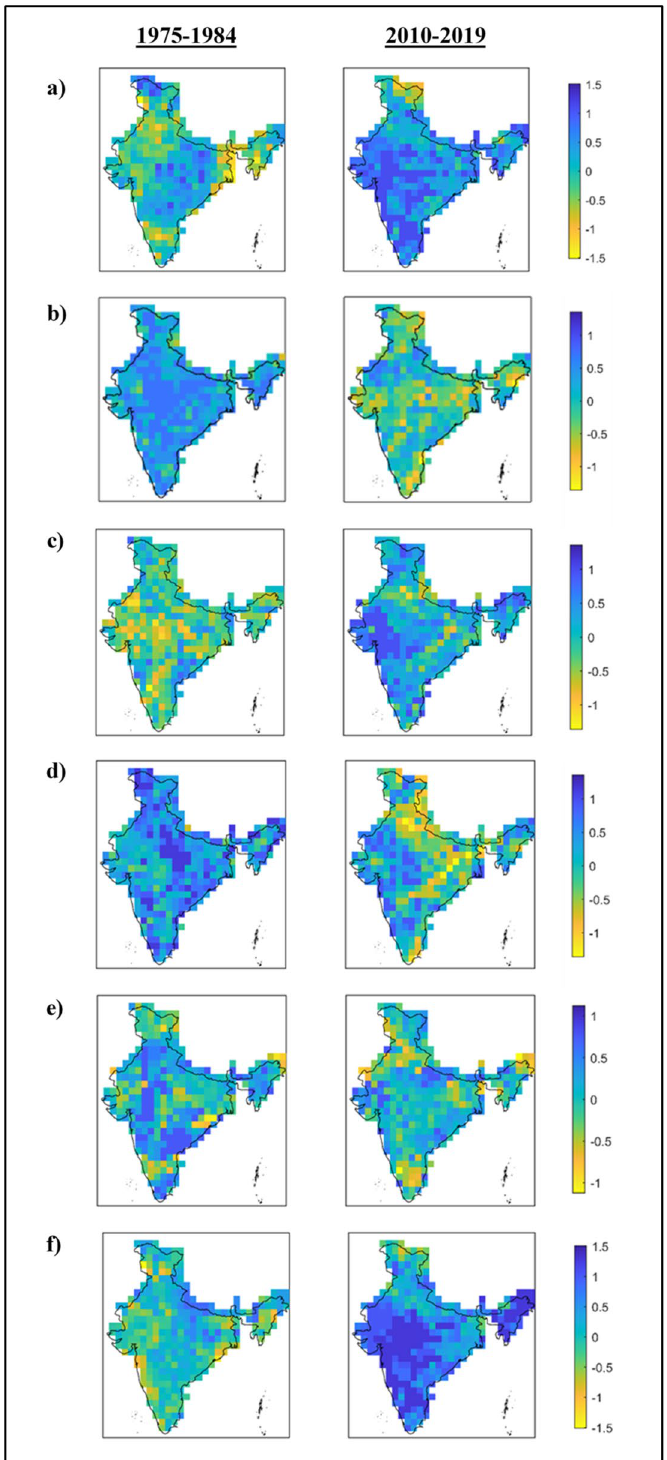
Figure 2. Spatial distribution of Joint Extreme Indices averaged over two decadal time periods i.e. 1975–1984 and 2010–2019 across India: ( a ) HNWD, ( b ) CWS, ( c ) WDS, ( d ) WWS, ( e ) CDS, ( f ) HWD. The figure was produced using MATLAB software (version R2021a, URL: https:// in. mathw orks.